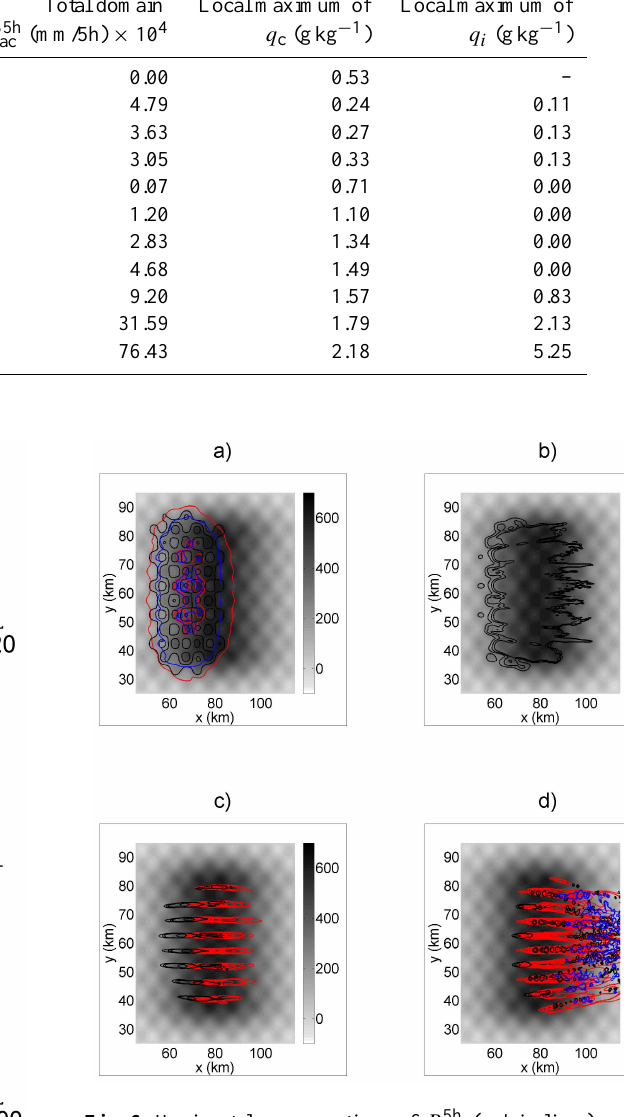
Fig. 6. Horizontal cross sections of P 5h ac (red isolines), q c fields at z q at 04:00h (black isolines) and q i at the level of its c max maximum intensity at 04:00h (blue isolines) from simulations (a) Sst10km_T272.5, (b) Sst10km_T277.5, (c) Sst10km and (d) Sst10km_T290. Grayscale represents topographic elevation (in me- and c max